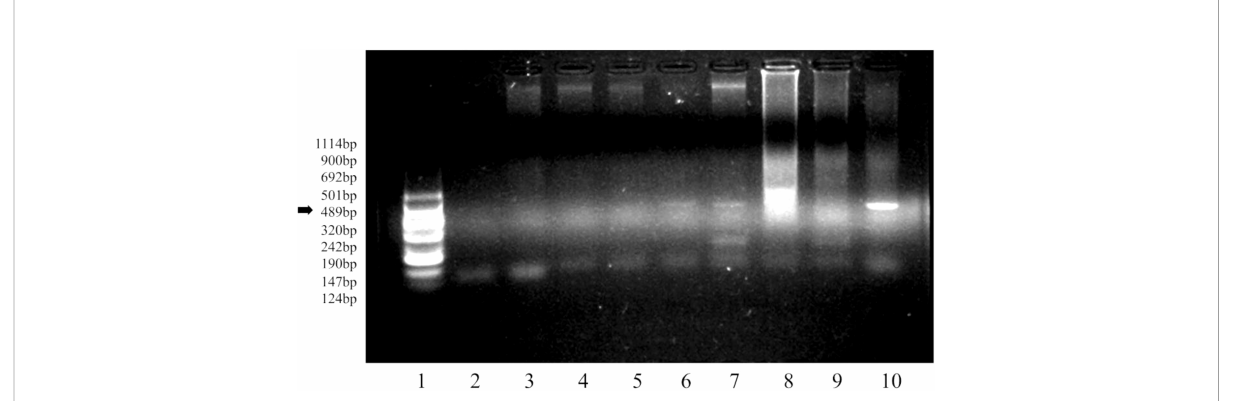
FIGURE 2 Detection of the KETc7 transgene by PCR. Agarose 1.5% gel in TBE 1X buffer, run for 1.30 h at 110 volts. Lane 1, molecular weight VIII (Roche); 2, primers A04/A05; 3, CF-WT line 3186; 4, CF-WT 0 ; 5, CF-WT 9 ; 6, CF-23 0 ; 7, CF-23 9 ; 8, genomic T. crassiceps DNA; 9, genomic T. solium cysticercus DNA; 10, KETc7/pUI235 genetic construct. The arrow indicates the expected molecular weight of the ampli fi ed DNA